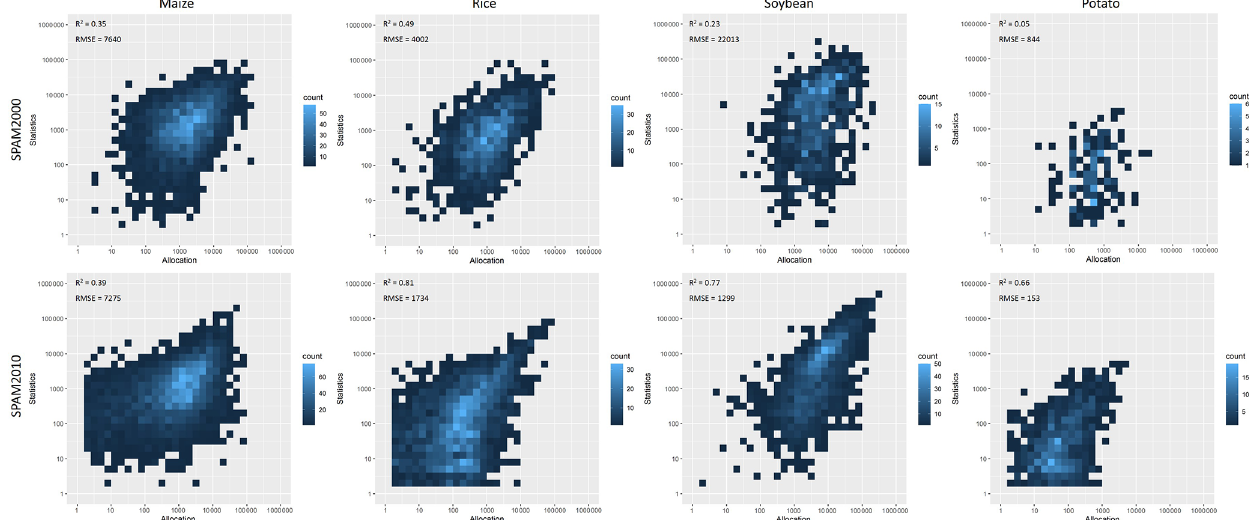
Figure 6. Comparison between the allocated crop area and statistics crop area at the ADM2 level in Brazil (log–log scale plot; unit: ha). The upper part is for SPAM2000 and the bottom part is for